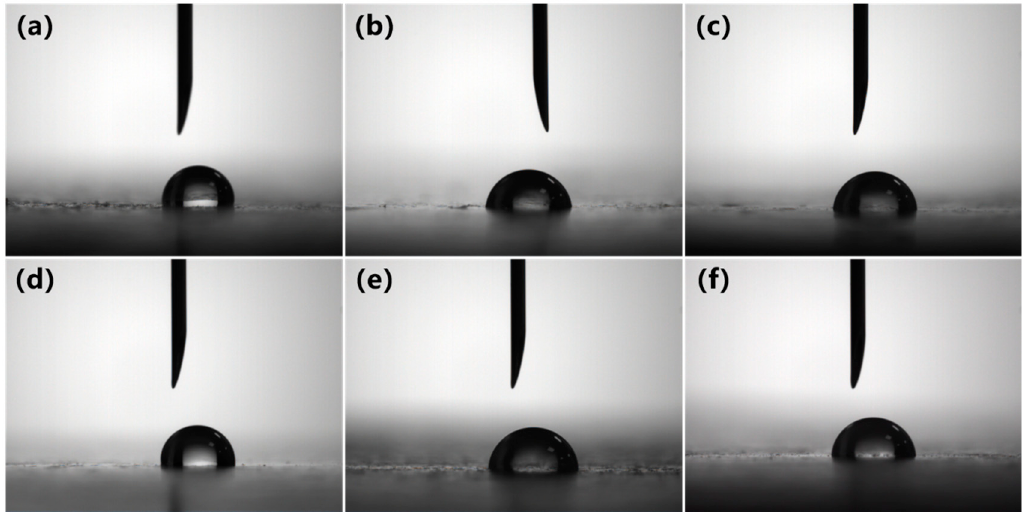
Figure 3. Surface contact angle images of the PVC biofilm carrier: ( a ) PVC, ( b ) PVC / PVA-5, ( c ) PVC / PVA-10, ( d ) PVC / mAC-PVA, ( e ) PVC / mAC-PVA-5, ( f ) PVC / mAC-PVA-10.